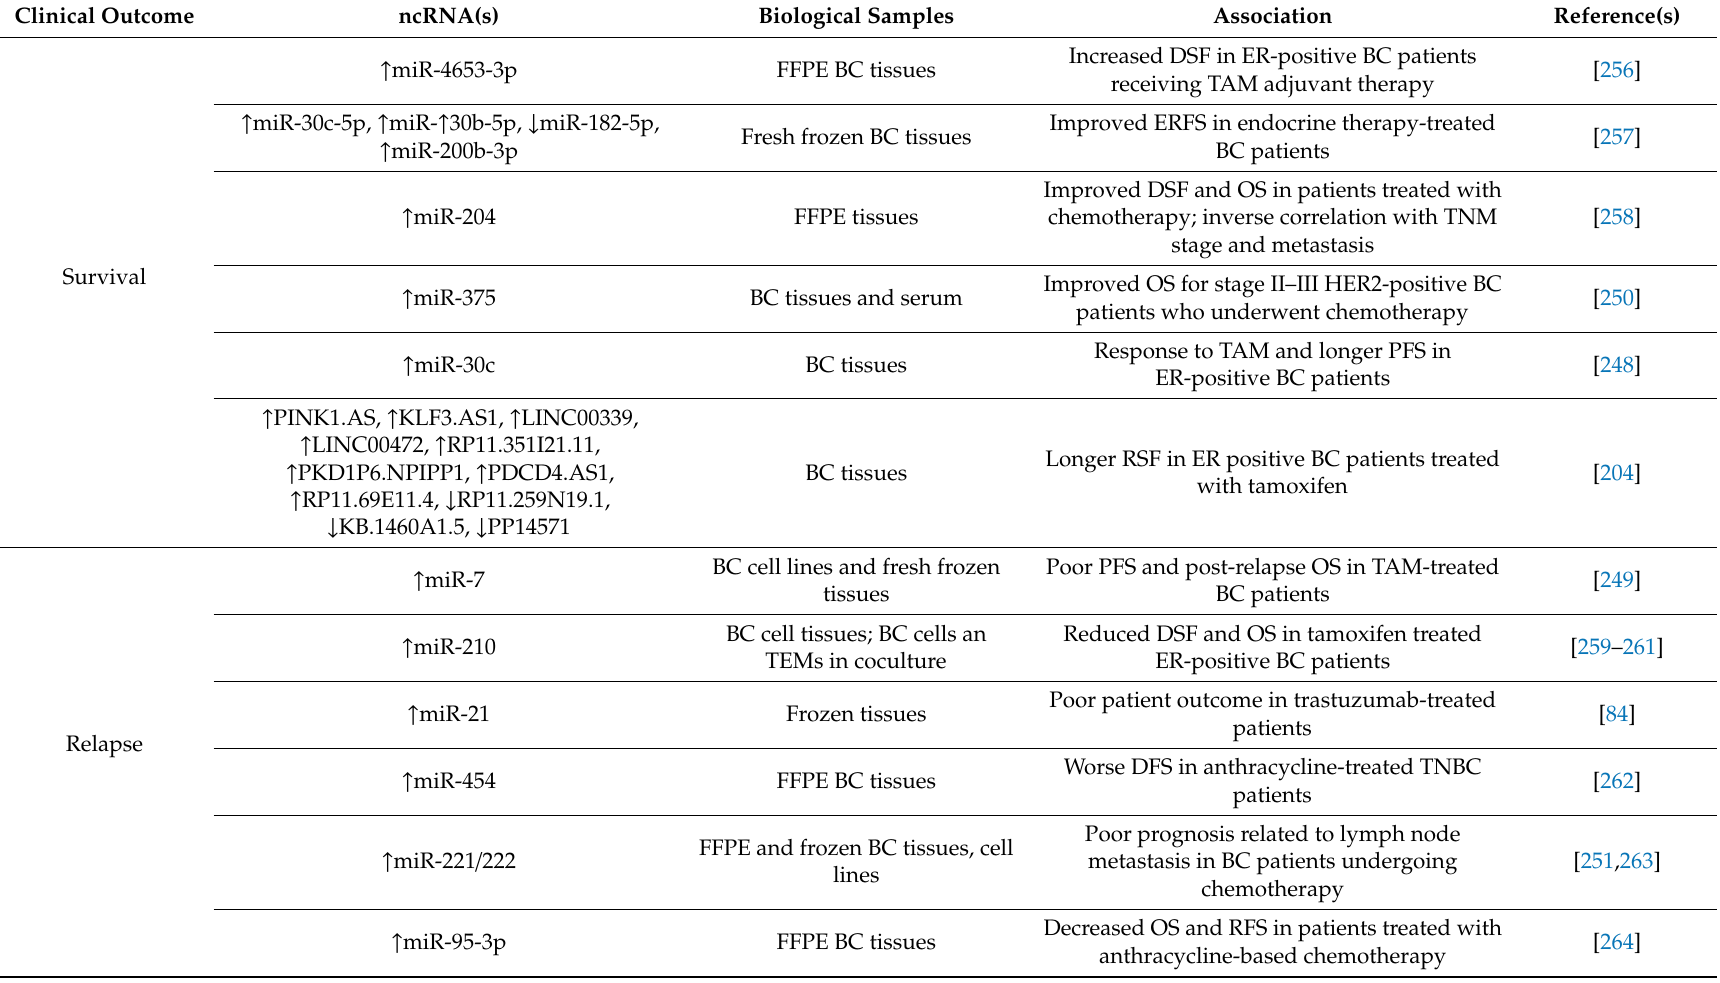
Table 7. Compendium of ncRNAs associated with the clinical outcome in BC 1 ; ( ↑ )–increased;( ↓